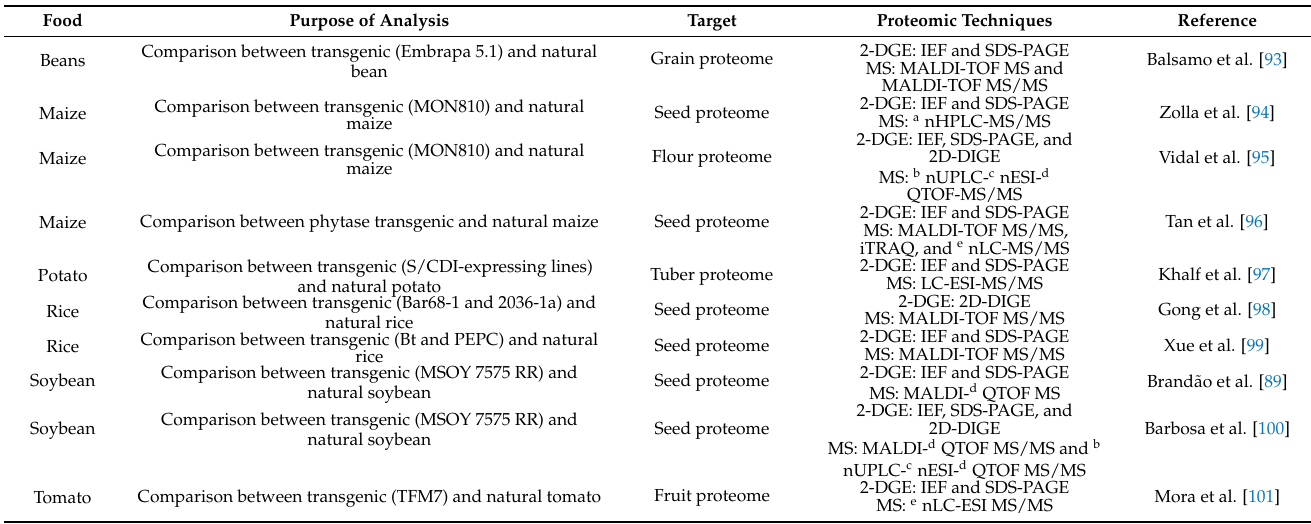
Table 3. Proteomic approaches for quality assessment in different genetically modified plant foods. Purpose of Analysis Target Proteomic